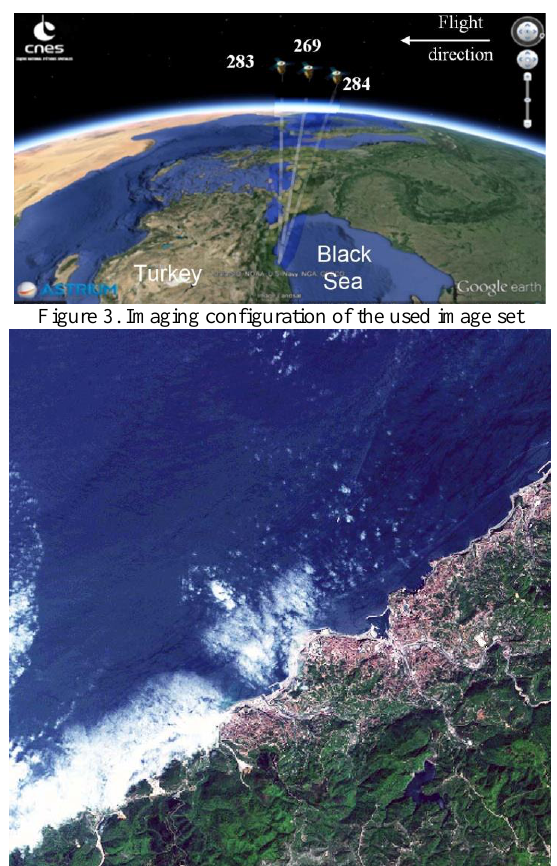
Figure 4. Sample of Pleiades images